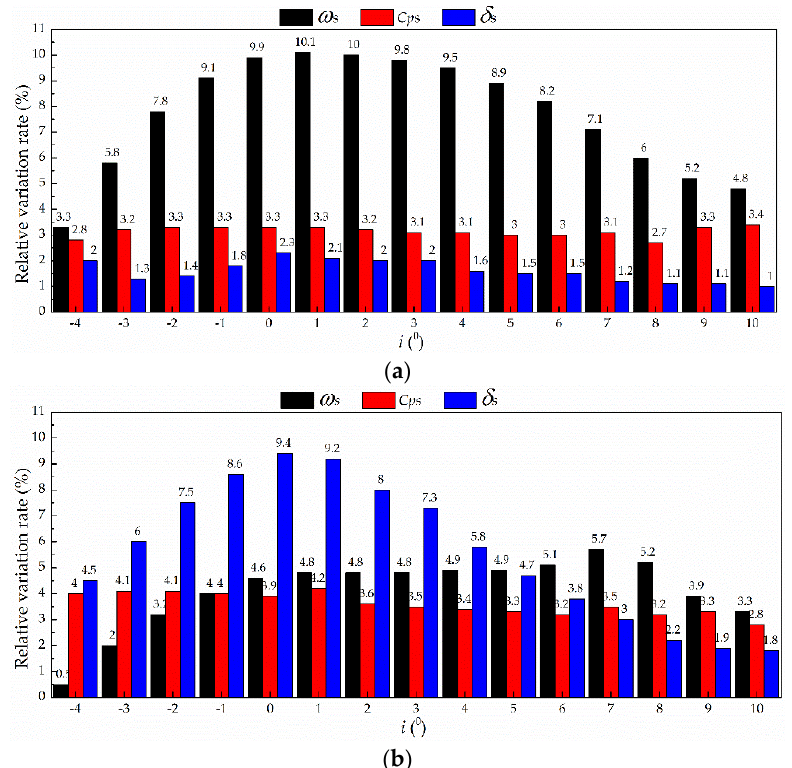
Figure 9. Influences of plasma actuations on the high-speed compressor cascade total pressure loss, static pressure rise, and blockage coefficients at different incidences. ( a ) Suction surface plasma actuation; ( b ) Endwall plasma actuation.